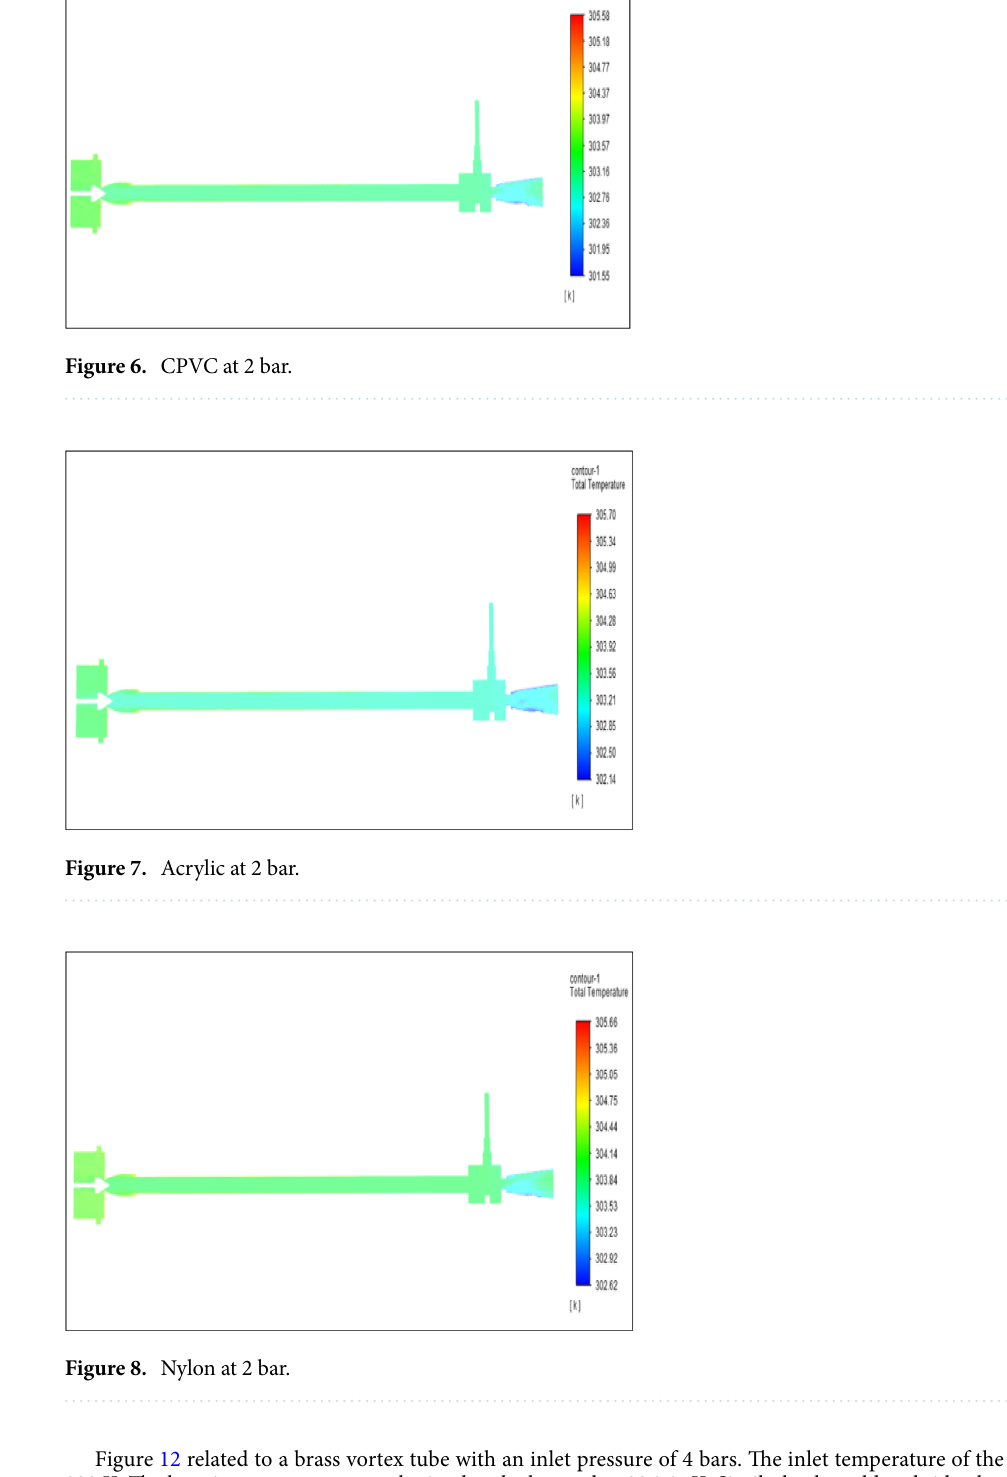
Figure 12 related to a brass vortex tube with an inlet pressure of 4 bars. The inlet temperature of the VT is 303 K. The hot air temperature was obtained at the hot end as 306.67 K. Similarly, the cold end side obtained a value of 300.88 K. The maximum temperature difference was found to be 5.79 K. Figure 13 represents to PVC Vortex tube with an inlet pressure of 4 bars. The inlet temperature of the VT is 303 K. The hot air temperature was obtained at the hot end as 305.56 K and at the cold end side obtained a value of 301.39 K. The maximum temperature difference was found to be 4.18 K.